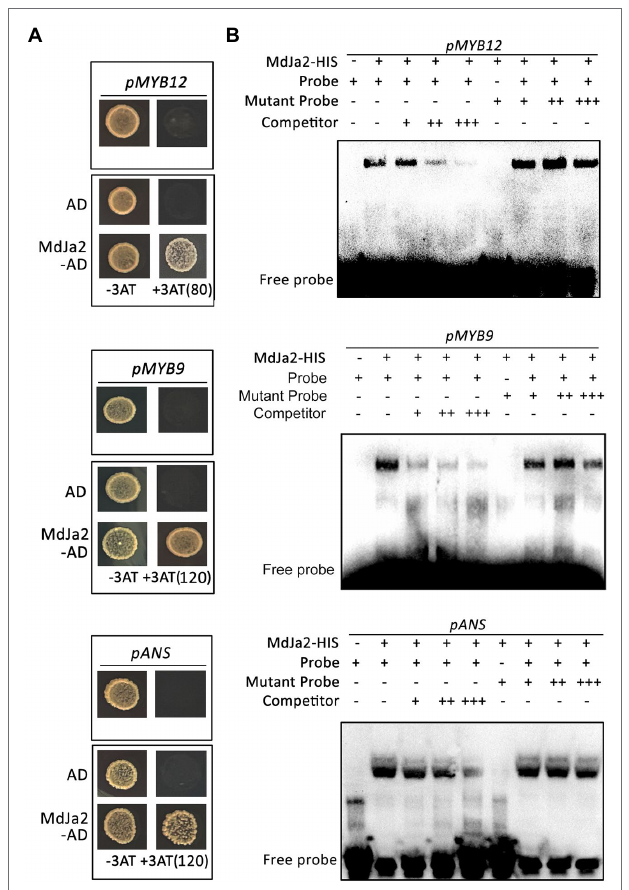
FIGURE 4 | MdJa2 binds to the MdANS , MdMYB9, and MdMYB12 promoters. (A) Yeast one-hybrid (Y1H) assays revealed the interactions between MdJa2 and pANS , pMYB9 , and pMYB12 . The pGADT7 + ANS- pHIS2 , pGADT7 + MYB9-pHIS2 , and pGADT7 + MYB12-pHIS2 co- transformations served as the controls. The numbers in parentheses indicated the optimal 3-AT concentrations for suppressing the background histidine leakiness of the pHIS2 vectors. (B) Results of the EMSAs. The probe was a biotin-labeled fragment. The competitor probe was an unlabeled probe. The mutant probe contained two nucleotide mutations. Competitor and mutant probes at 50×, 100× and 200× molar excess were present (+) or absent ( − ) in each reaction. The bindings between MdJa2 and the MdANS , MdMYB9 and MdMYB12 promoters were weakened with increasing competition probes concentrations. When the probes were mutated two nucleotides in the binding sites, MdJa2 did not bind to the MdANS , MdMYB9, and MdMYB12 promoters. However, when the mutant probes and the biotin-labeled probes were added together, their bindings between them were not